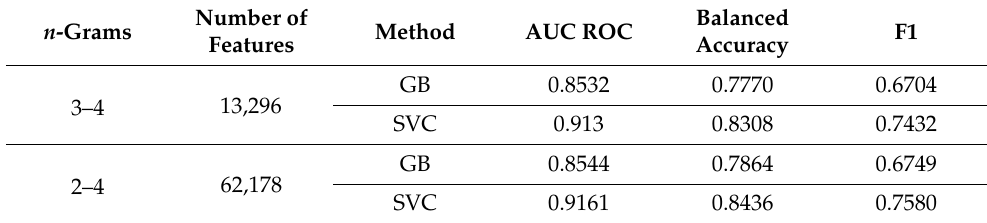
Table 9. The classification results by symbols for a data set from a poem no shorter than 16 lines. n